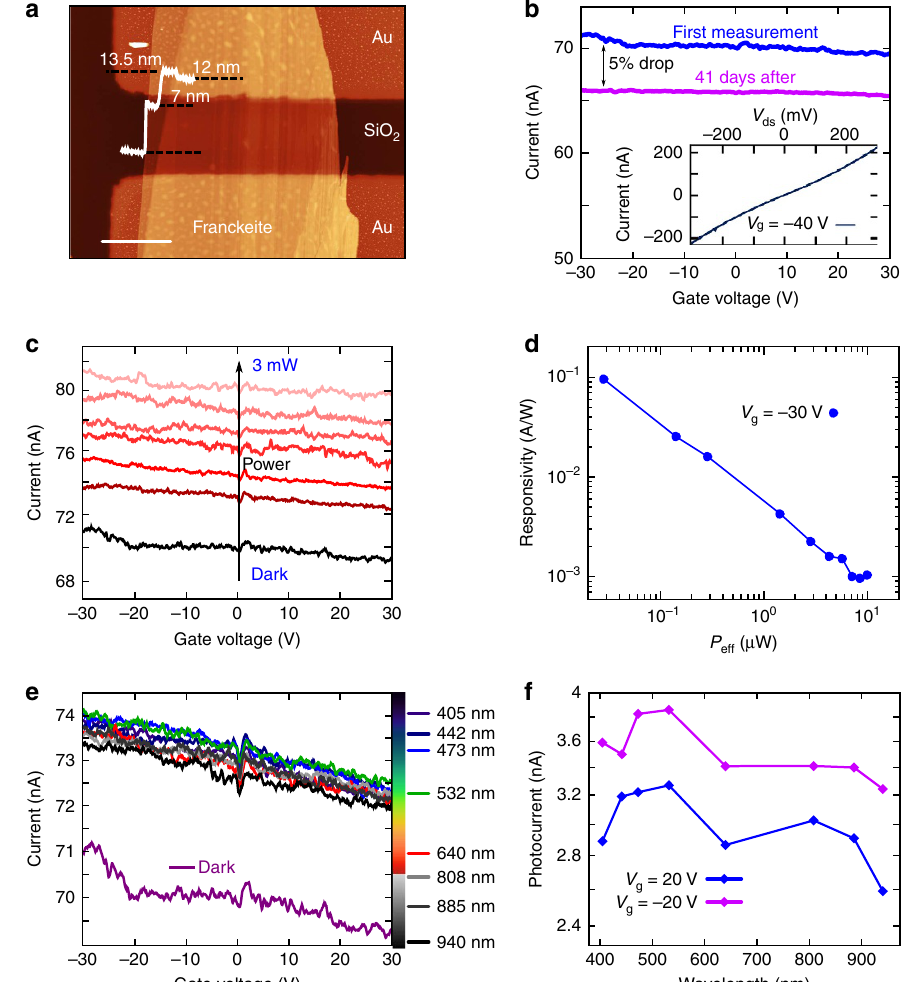
Figure 4 | Franckeite-based nanodevices. ( a ) AFM topographic image of a franckeite flake deposited on SiO 2 substrate with pre-patterned Ti/Au electrodes. The thickness of the flake ranges from 7nm ( B 4 layers) to 13.5nm ( B 8 layers). The scale bar is 7 m m. ( b ) Current as a function of the applied back-gate voltage in dark conditions for the device shown in a ( V ds ¼ 150mV). The gate-dependence shows a p-type doping, hole conduction. The first measurement (blue line) was repeated after 41 days (pink line), showing a drop of 5%, yielding a good stability of the device. Inset: current-voltage curve with an applied back-gate voltage of (cid:3) 40V. ( c ) Current as a function of the applied back-gate voltage ( V ds ¼ 150mV) for the device shown in a in dark conditions and upon illumination with a 640nm wavelength laser with different powers. ( d ) Responsivity of the device shown in a upon illumination with a 640nm wavelength laser as a function of the laser effective power with an applied back-gate voltage of V g ¼ (cid:3) 30V and V ds ¼ 150mV. ( e ), Current as a function of the applied back-gate voltage ( V ds ¼ 150mV) for the device shown in a upon illumination with lasers of different wavelengths at the same intensity ( P d ¼ 6.3mW (cid:2) cm (cid:3) 2 ). There is photocurrent generation even at wavelengths as large as 940nm. ( f ) Photocurrent as a function of the laser wavelengths with the same light intensity for back gate voltages of (cid:3) 20V and þ 20V and V ds ¼